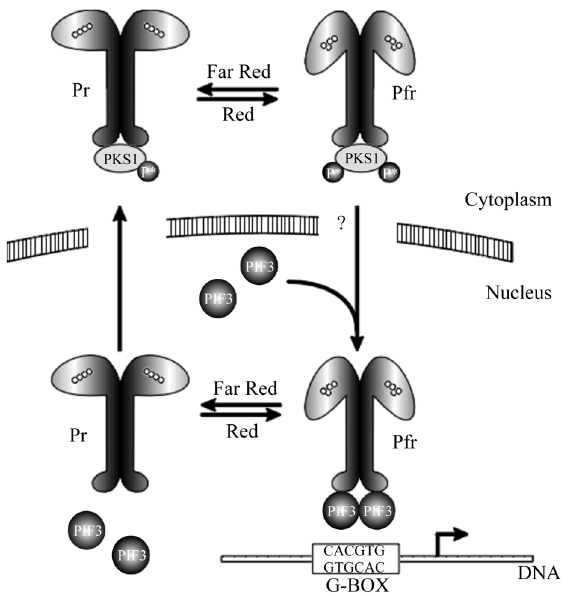
Figure 1 - The scheme (modified from Smith, 1999) is based on the data from Quail’s and Chory’s groups on PIF3 and PKS1. Phytochromes are represented by their dimeric form. They oscillate between an inactive state ( Pr) and an activated ( Pfr) form, under far-red or red light, respec- tively. The mechanism which govern the nucleo-cytoplasmic partitioning ofphytochromesareoflimitedinformationinhigherplants.PKS1hastwo possible levels of phosphorylation and may act as a docking protein in the less phosphorylated state. The possibility of PIF3 associating with other transcription factors that also recognize the G box motif has been sug- gested. The symbol oooo represents tetra-pyrrol - P phosphorylated resi- due in PKS1 (see